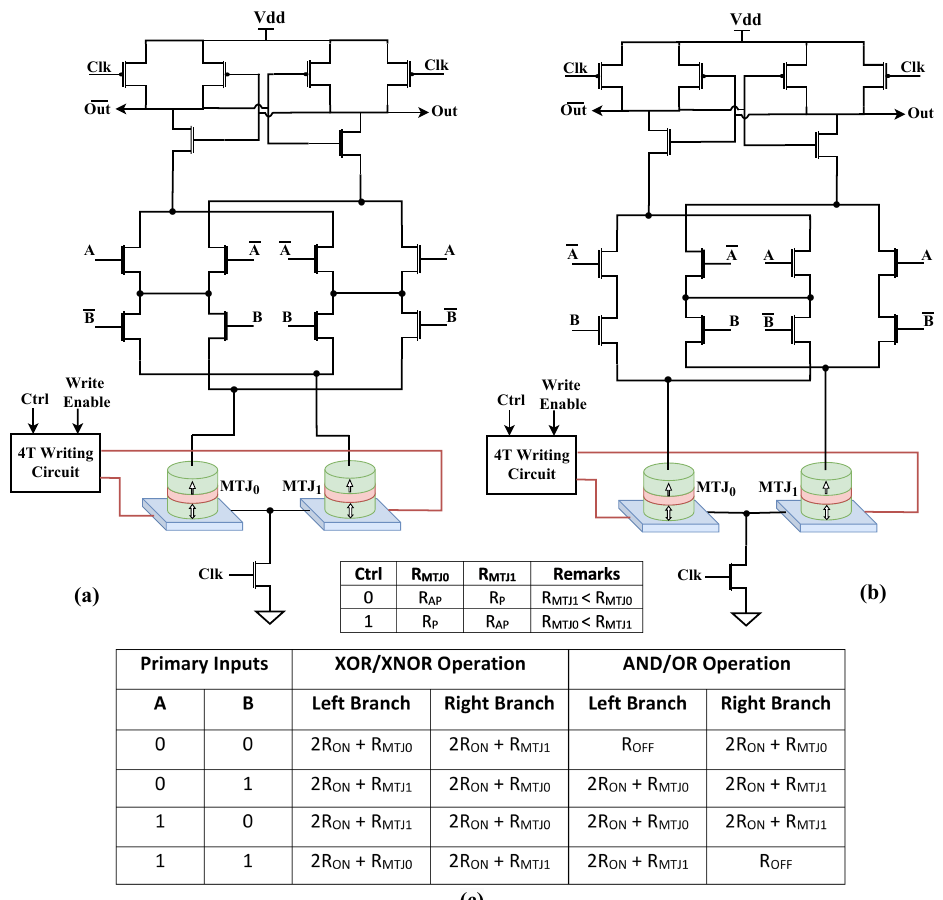
Figure 2. Hybrid CMOS-MTJ-structure-based circuits utilizing a four-transistor writing circuit for performing ( a ) XOR/XNOR operation and ( b ) AND/OR operation. ( c ) Truth table with corresponding resistance value of left and right branch of PCSA. NMOS logic structures from [46] were